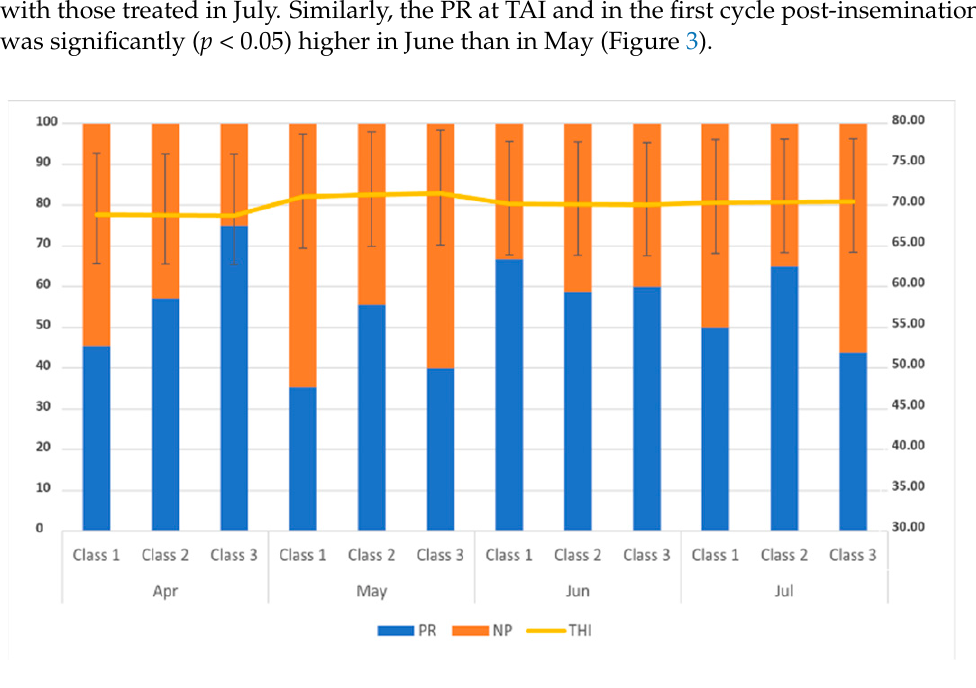
Figure 3. Pregnancy risk recorded in different months in buffaloes with different days in milk (Class I: <90 DIM; Class II: 91–150 DIM; Class III: >151 DIM) and THI values recorded throughout the study. The average THI throughout the study was 70.2 ± 0.42. No influence of THI on the total pregnancy rate was recorded. In particular, when the animals were divided into the four classes of THI, pregnancy rates of 43.3, 52.2, 59.7, and 57.5 were recorded in Classes A, B, C, and D, respectively. Furthermore, the multiple linear regression analysis only showed a significant ( p < 0.01) influence of BCS at TAI on the follicular area (r 2 = 0.242), according to the following equation: